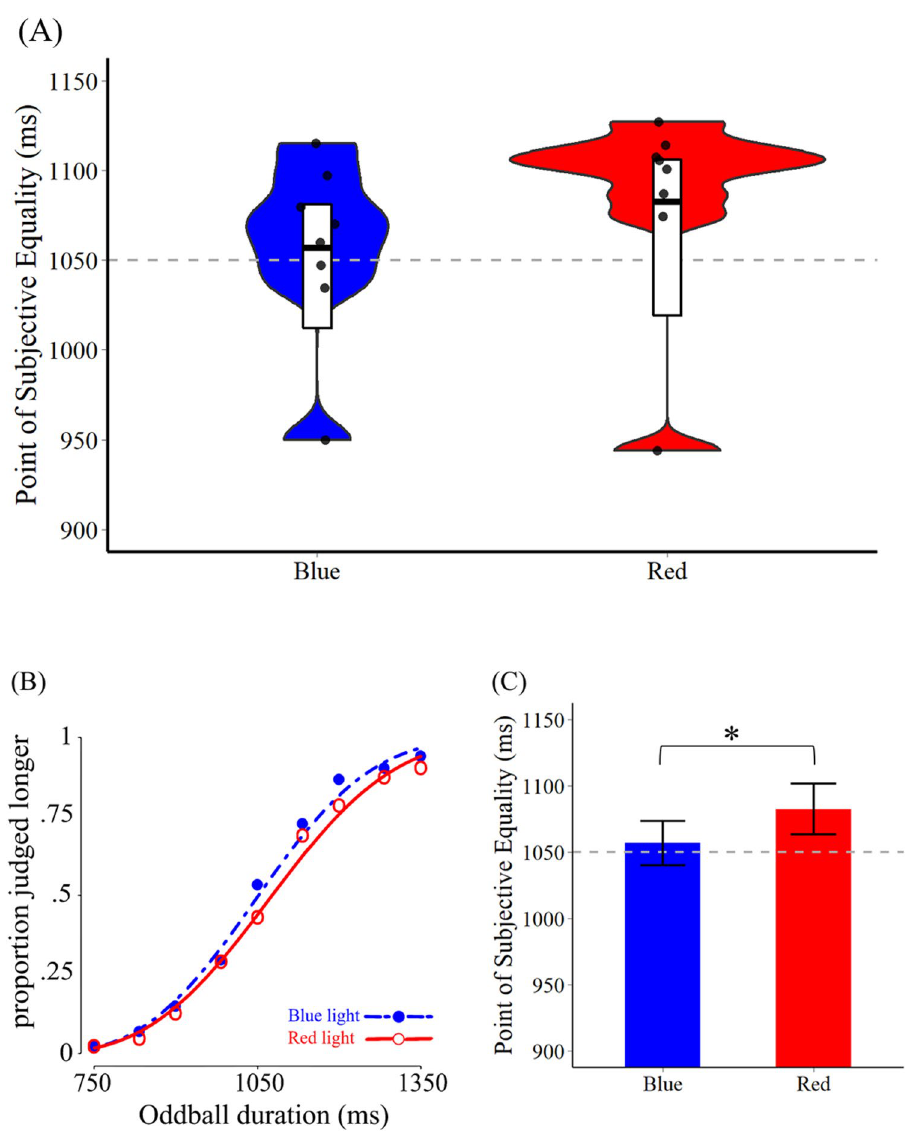
Figure 2. Results of Experiment 1. ( A ) The fitted PSE for blue and red light conditions in Experiment 2. The white bar in the middle indicates the bootstrapped 95% confidence intervals of each condition and the black horizontal line in the middle is the group mean. Each dot represents one participant’s fitted PSE value. The gray dashed line in the middle shows the duration of standard stimuli (1050 ms). ( B ) The group-averaged psychometric functions. ( C ) The PSE in the blue vs. red light conditions with bootstrapped 95% confidence intervals. The PSE under blue light was significantly smaller than that under red light, indicating a longer perceived duration under blue light than red light.